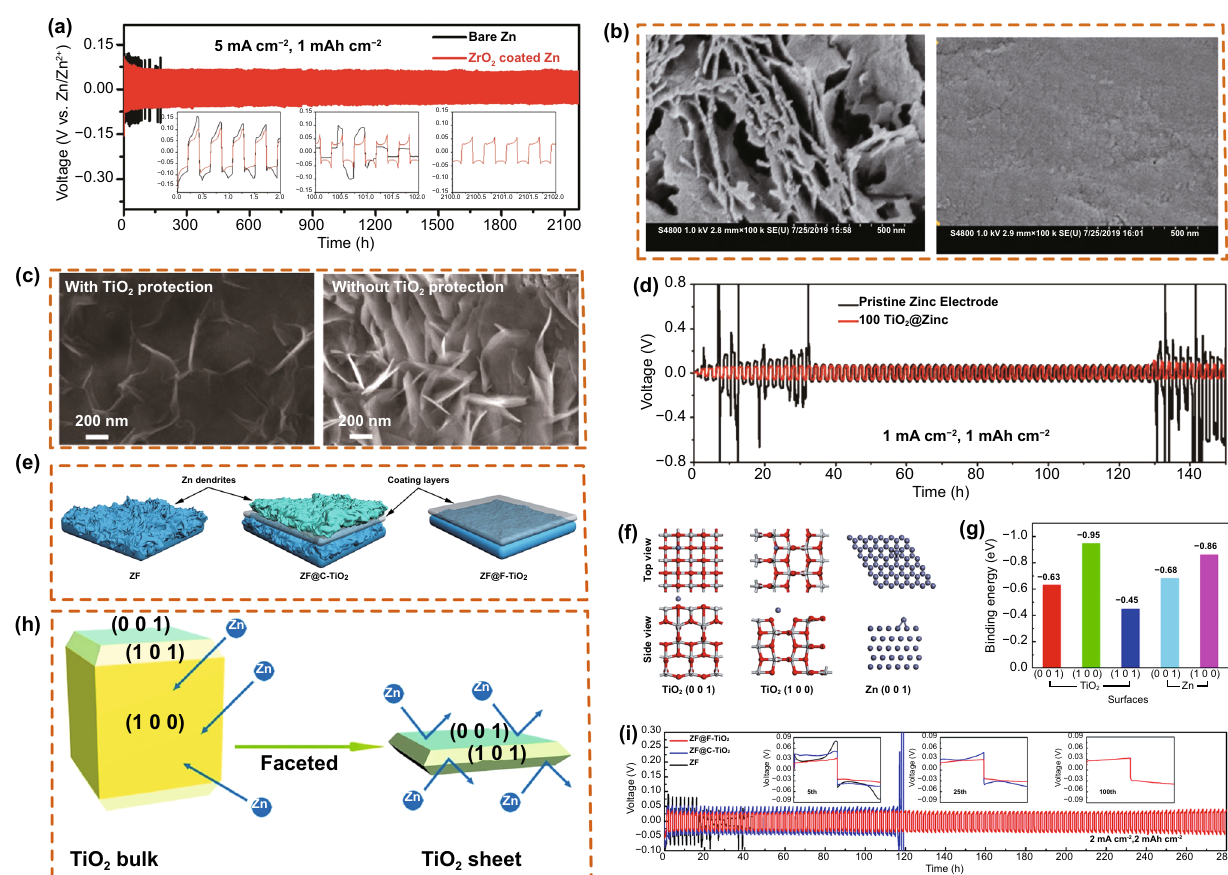
Fig. 7 a Voltage profiles of metallic Zn stripping/plating in a bare Zn and ZrO 2 -coated Zn symmetrical full-cell at 5 mA cm −2 for 1 mAh cm −2 . b Digital images and corresponding SEM images of a bare Zn and ZrO 2 -coated Zn anode after 100 cycles at 5 mA cm −2 with 2.5 mAh cm −2 . Copyright 2020 Royal Society of Chemistry [55]. c Ex situ SEM images of 100TiO 2 @Zn and a pristine Zn anode. d Cyclic stripping/plating process of symmetrical cells using 100TiO the Zn plating process with different coating layers. f Calculation models of Zn absorbed on a TiO 2 (0 0 1) facet, TiO 2 (1 0 0) facet, and Zn (0 0 1) facet. g Calculated binding energies of Zn atom with different facets. h Schematic illustration of the interaction between Zn and anatase TiO 2 with different exposed facets. i Cycling performance of Zn||Zn symmetrical cells at 2 mA cm −2 for 2 mAh cm −2 . Copyright 2020